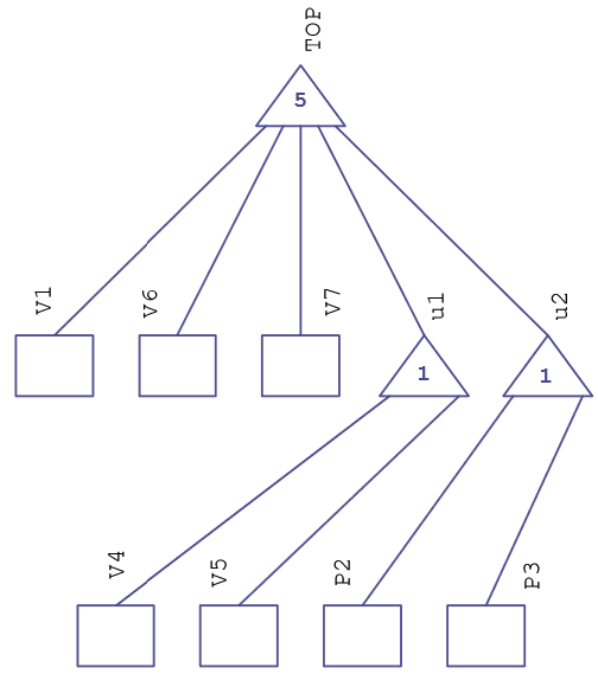
Figure 1. Directed acyclic graph of a system from practice. Internal nodes are denoted by blue triangles, e.g., u1 or u2, respresenting subsystems of the fluid system. Subsystems as well as components (i.e., internal respectively terminal nodes) at a given time are either correctly working or in a failed state (under